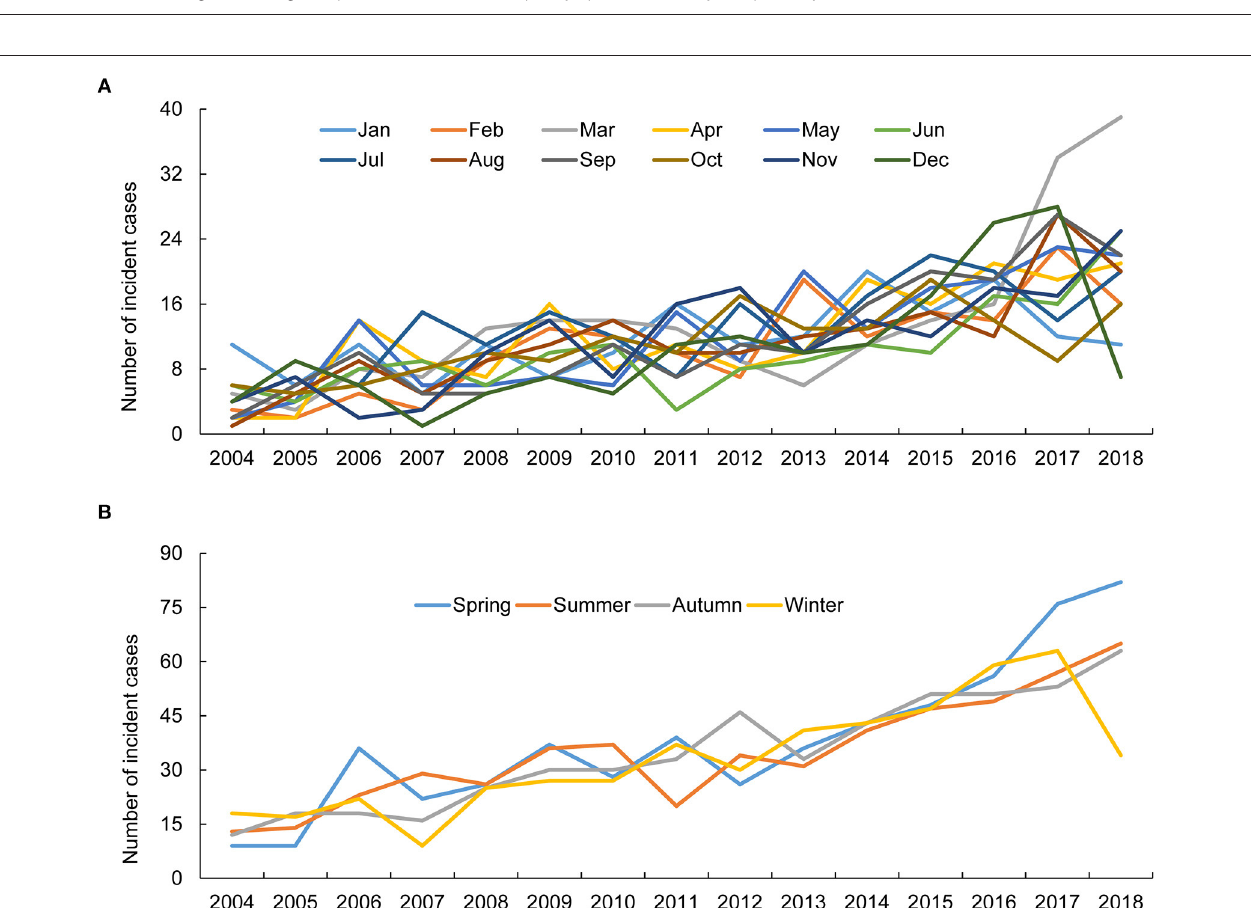
FIGURE 2 | Monthly and seasonal incidence of ANCA-associated vasculitis. The difference in AAV incidence was not apparent according to the (A) month and (B) season. ANCA, antineutrophil cytoplasmic